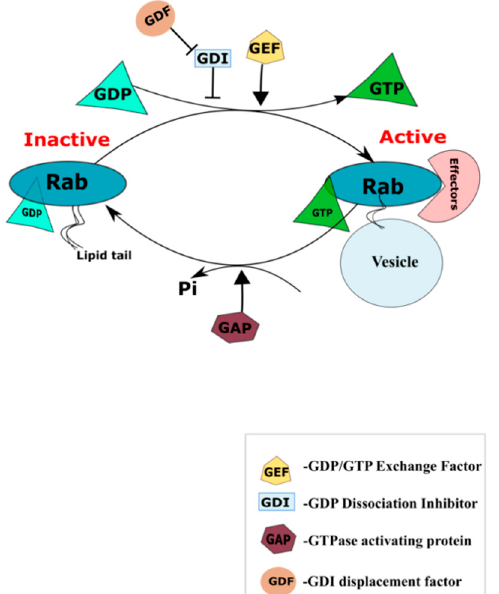
Figure 2. Rab activation cycle. GDP / GTP exchange factors (GEFs) mediate Rab activation by